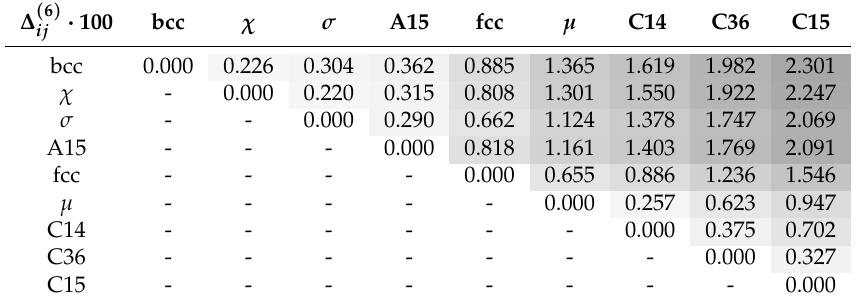
Table 2. Similarity matrix of TCP phases in terms of the distance in moments space ∆ ij . The entries are ordered by increasing difference to bcc. The symmetric lower-left part is omitted for brevity. The grey scale reflects the numerical entries and is included to guide the